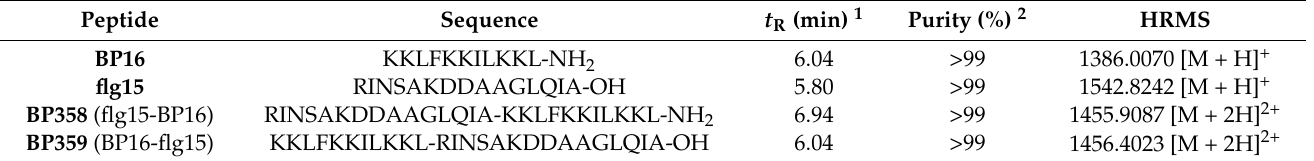
Table 1. Sequences, retention times, HPLC purities, and mass spectrometry data of the peptides. Peptide Sequence t R (min) 1 Purity (%) 2 HRMS BP16 KKLFKKILKKL-NH 2